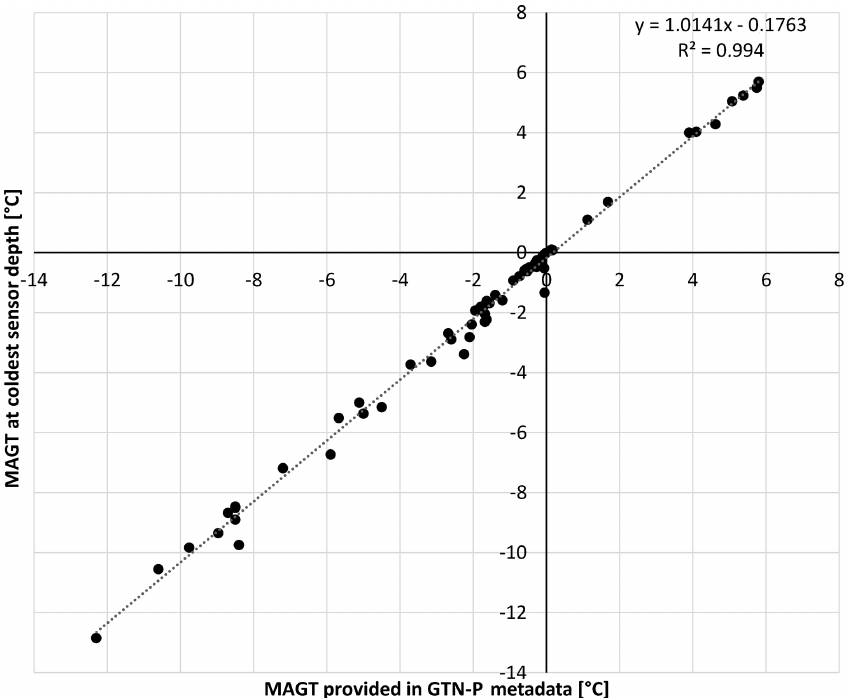
Figure 2. Mean annual ground temperature (MAGT) derived from metadata (at or close to zero annual amplitude) versus derived MAGT c from the coldest sensor (for year of MAGT specified in the metadata) based on GTN-P borehole records. The dotted line represents the linear fit. Table 1. Comparison between in situ mean annual ground temper- ature (MAGT c , at the coldest sensor depth) with number of frozen days per year from ASCAT (FT – excluding snow melt days; FM – including snow melt days) and SSM/I for 2007–2012.